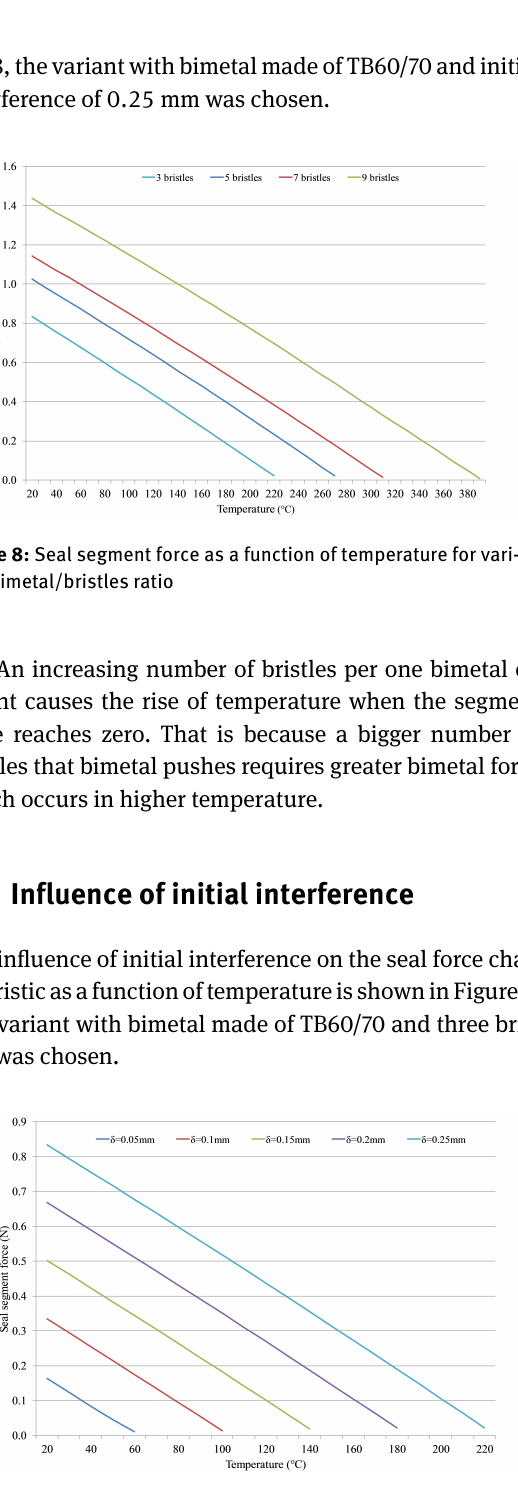
Figure 9: Seal segment force as a function of temperature for vari- ous initial interference value